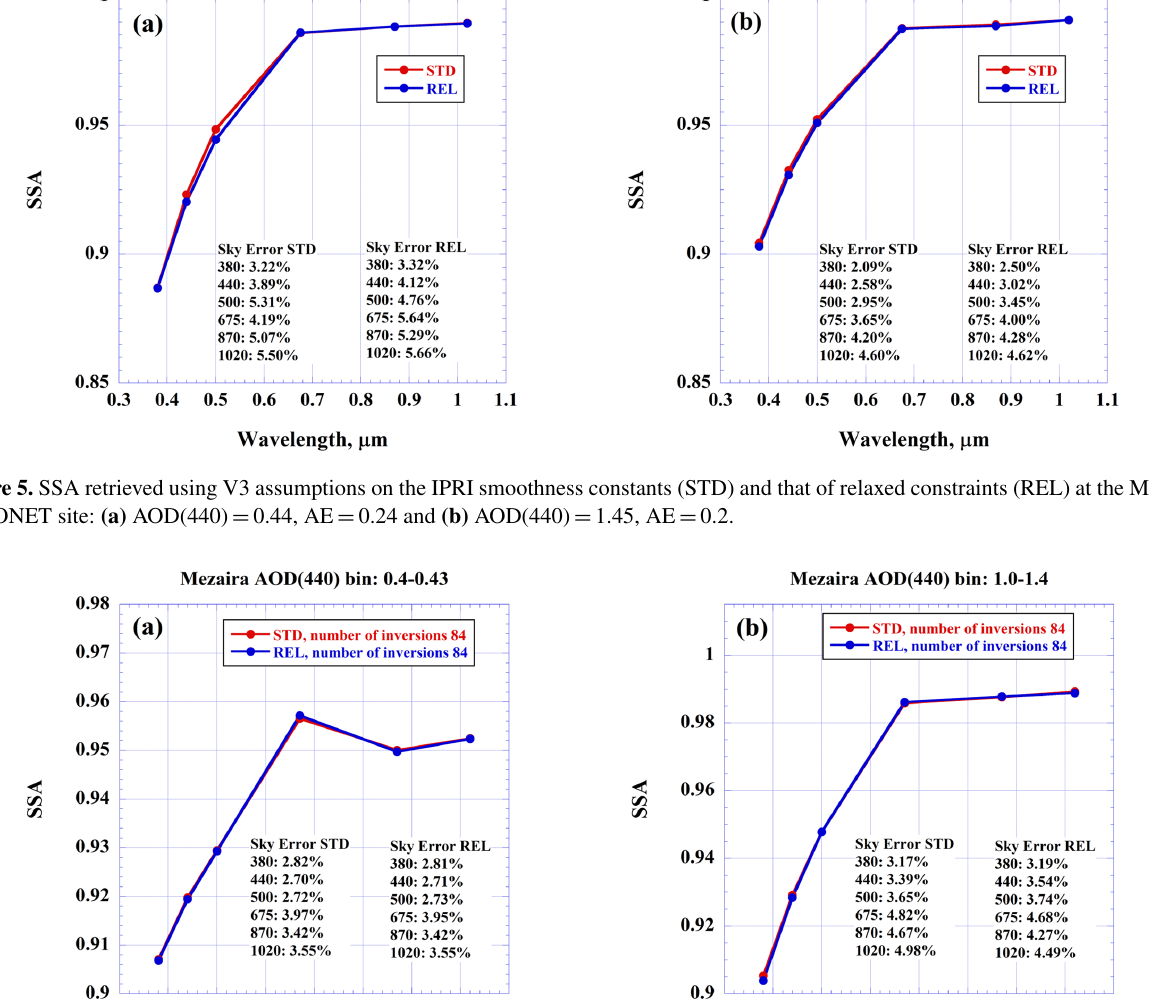
0.0074, 0.0163 and 0.021, respectively, which is within